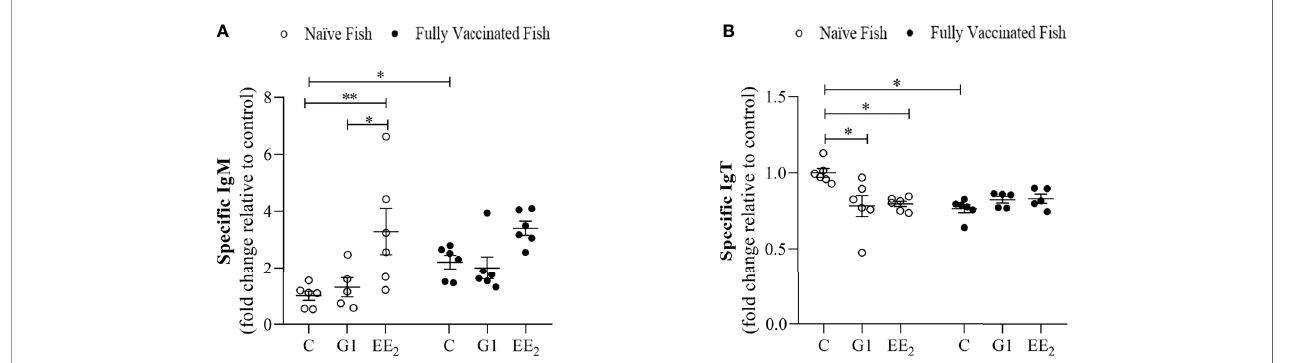
FIGURE 9 | Vaccination differentially regulates the activity induced by the oral exposure to xenoestrogens on the systemic and mucosal antibody production in the gilthead seabream. The anti-KLH IgM and IgT levels ( A and B , respectively) in fi sh dietary treated with G1 or EE2 (5 m g/g food) for 84 days and either vaccinated following priming and boosted doses of KLH or not (naive) are shown. Data were obtained in duplication by ELISA using independent biological samples and represent means ± standard error (n=6). Asterisks denote statistically signi fi cant differences between the groups. Data were analyzed by ANOVA with a post hoc Tukey-Kramer multiple comparison test,